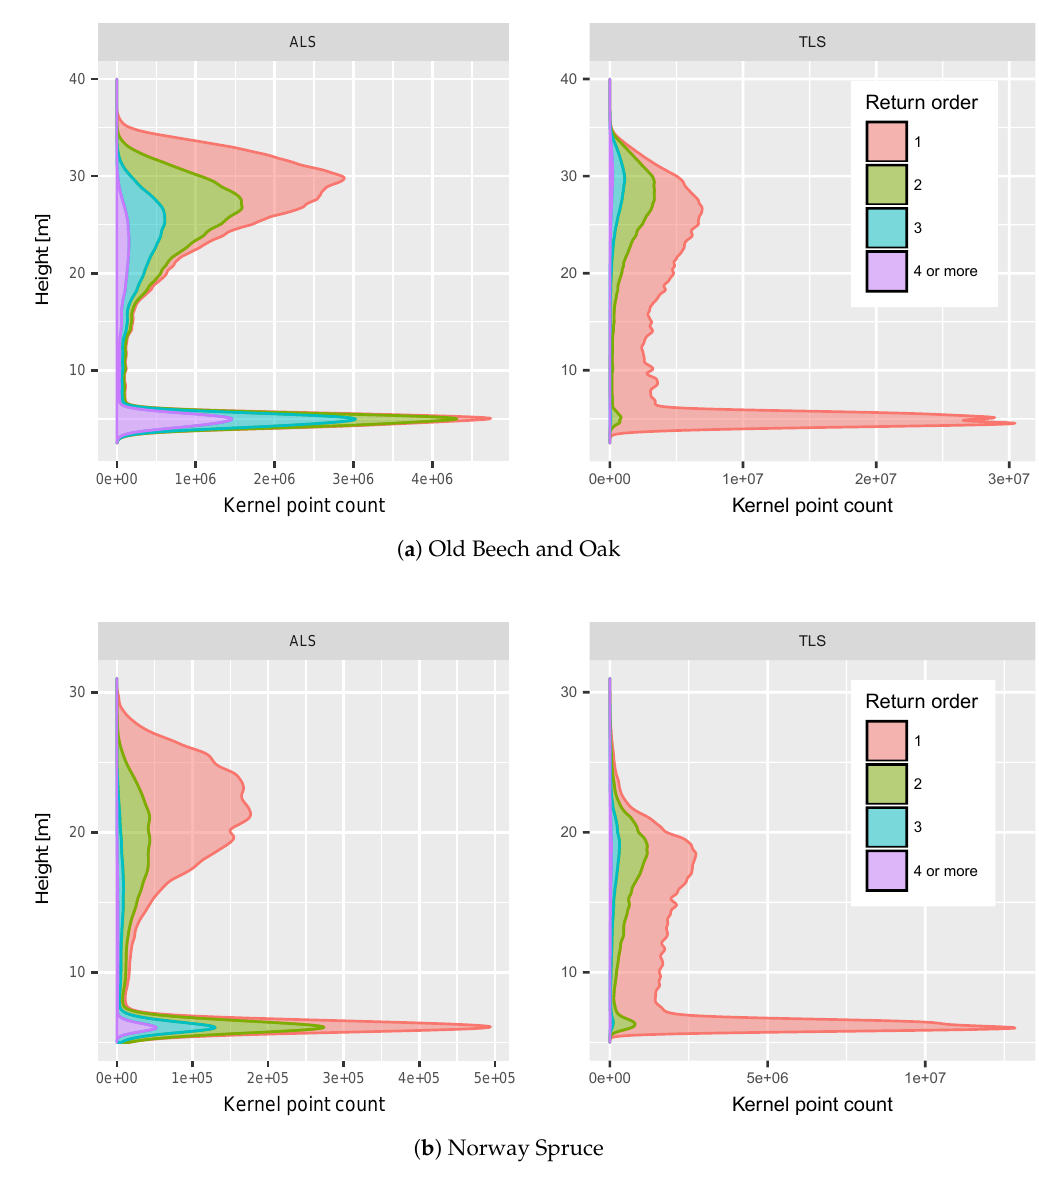
Figure 5. Vertical return density profiles smoothed with Gaussian kernel of all points in two areas of interest (see Figure 2), height reference is lowest point found in sub-area.